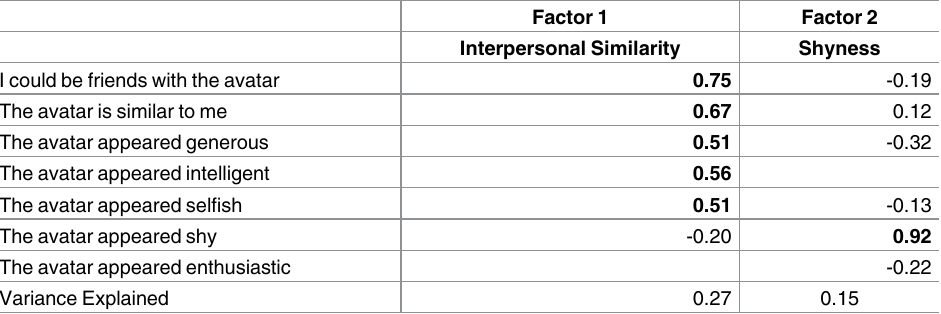
Table 2. Factor loadings for the Interpersonal Distance Questionnaire. Loadingsgreater than |0.4| are in bold as these items contribute most to the meaningof a factor. Loadings less than |0.1| are omitted for